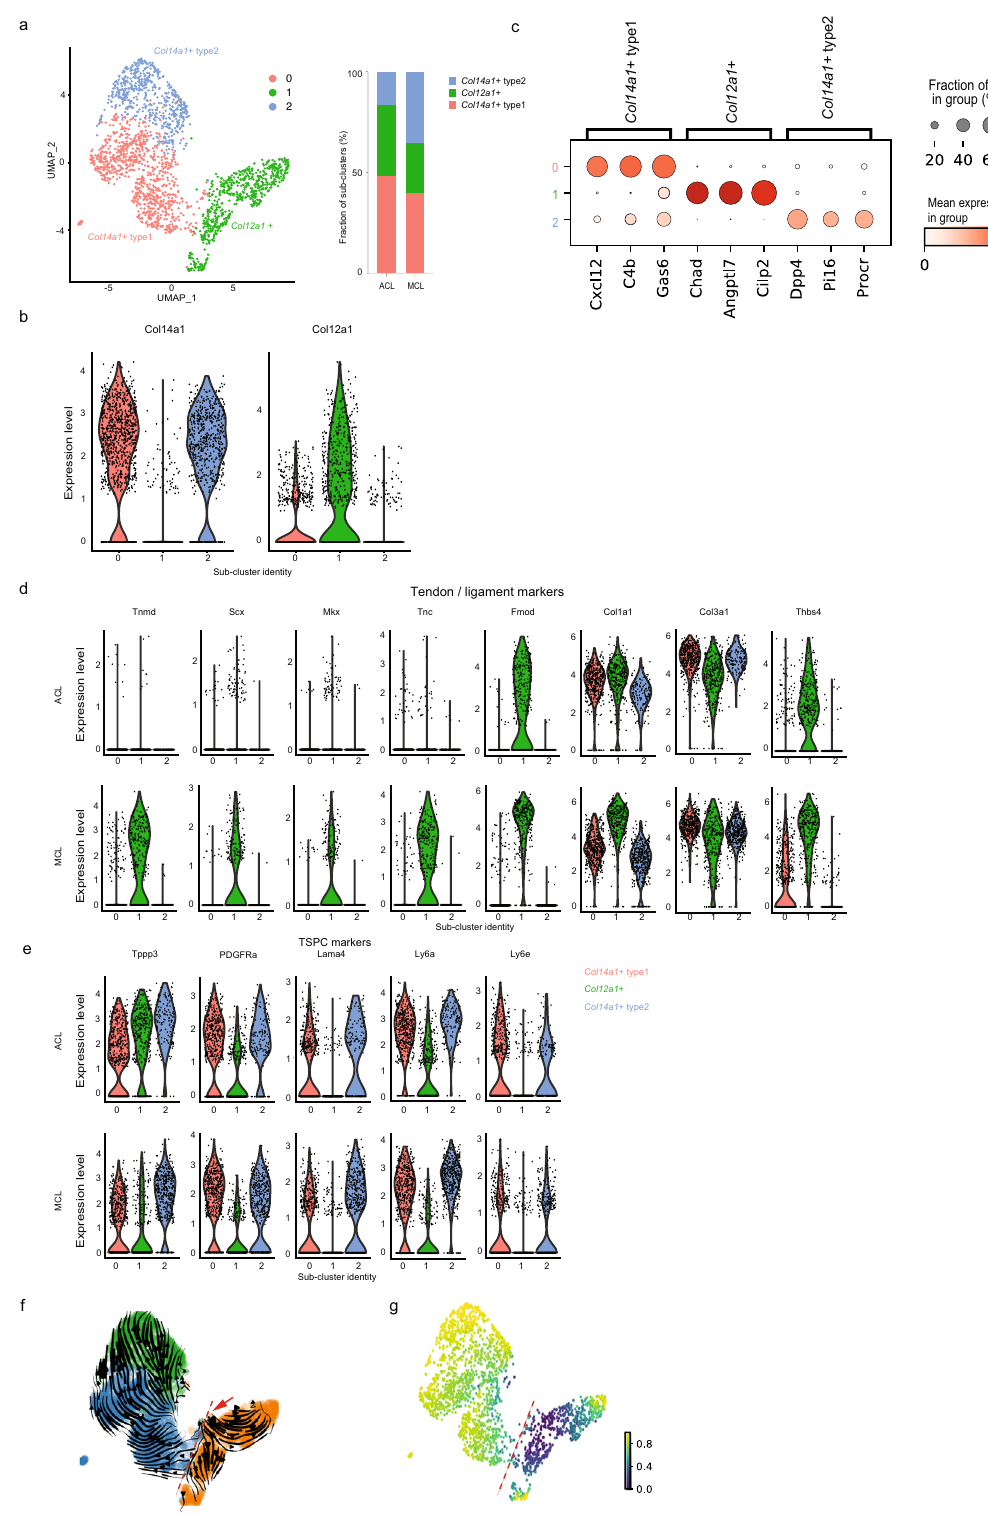
Fig. 4 Further analysis of Col12a1 - and Col14a1 -positive cells reveal cellular heterogeneities in the ACL and MCL. a Left: further sub-clustering analysis of Col14a1 - and Col12a1 -positive cells identi fi ed 3 distinct sub-populations. Right: fraction of each sub-cluster in the ACL and MCL. b Violin plots of sub-clusters indicate the expression level of Col14a1 and Col12a1 . c Marker genes for each sub-cluster are illustrated. Dot size represents the percentage of cells expressing a gene within a cluster. The intensity of the dot color indicates the mean expression level. d Violin plots of tendon/ligament markers in the ACL and MCL. e Violin plots of TSPC markers in the ACL and MCL. f RNA velocity analysis showing cellular dynamics in fi broblasts. The red arrow indicates the root of velocity kinetics. The red dot indicatesthe border by which Col12a1- positivecells and Col14a1- positive cells are separated. g Pseudotime analyses showing inferred ordering of cells.